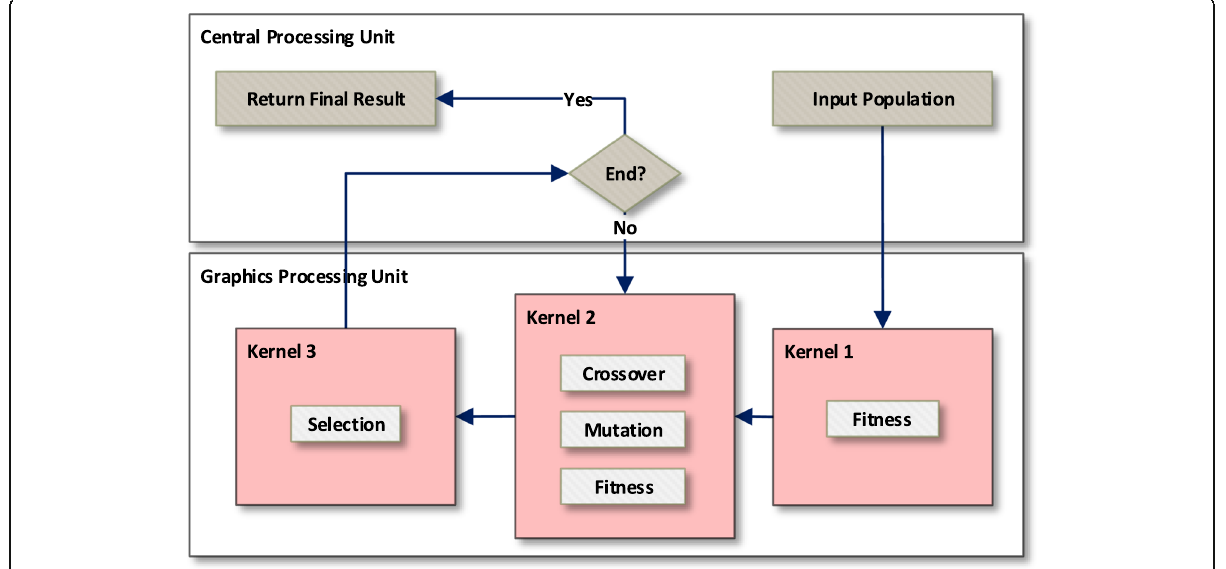
Fig. 4 Parallel approaches for running Genetic